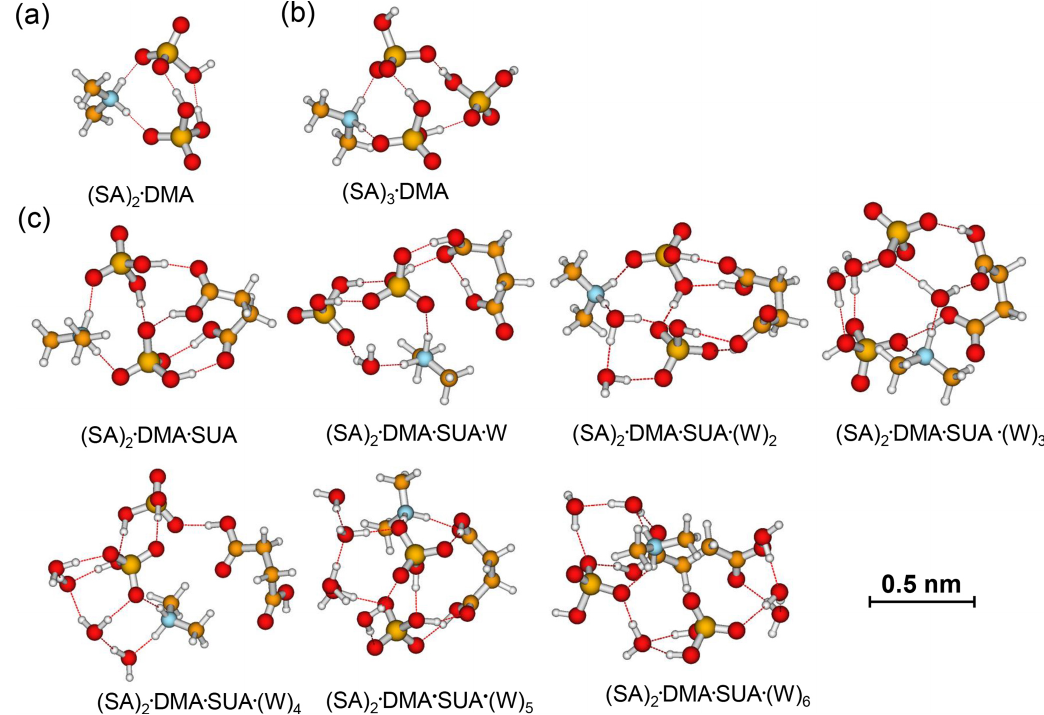
(cid:113) (cid:113) DMA, (b) (SA) 2 DMA, and (c) the hydrated (SA) 2